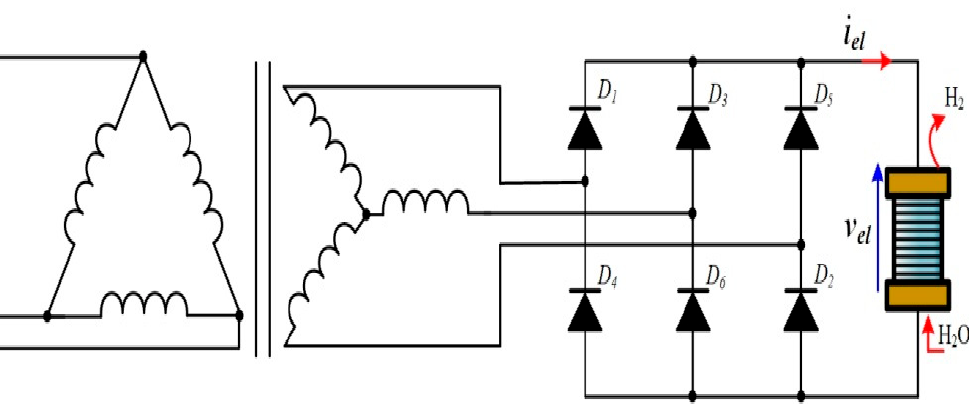
Figure 4. Six-pulse diode bridge rectifier.